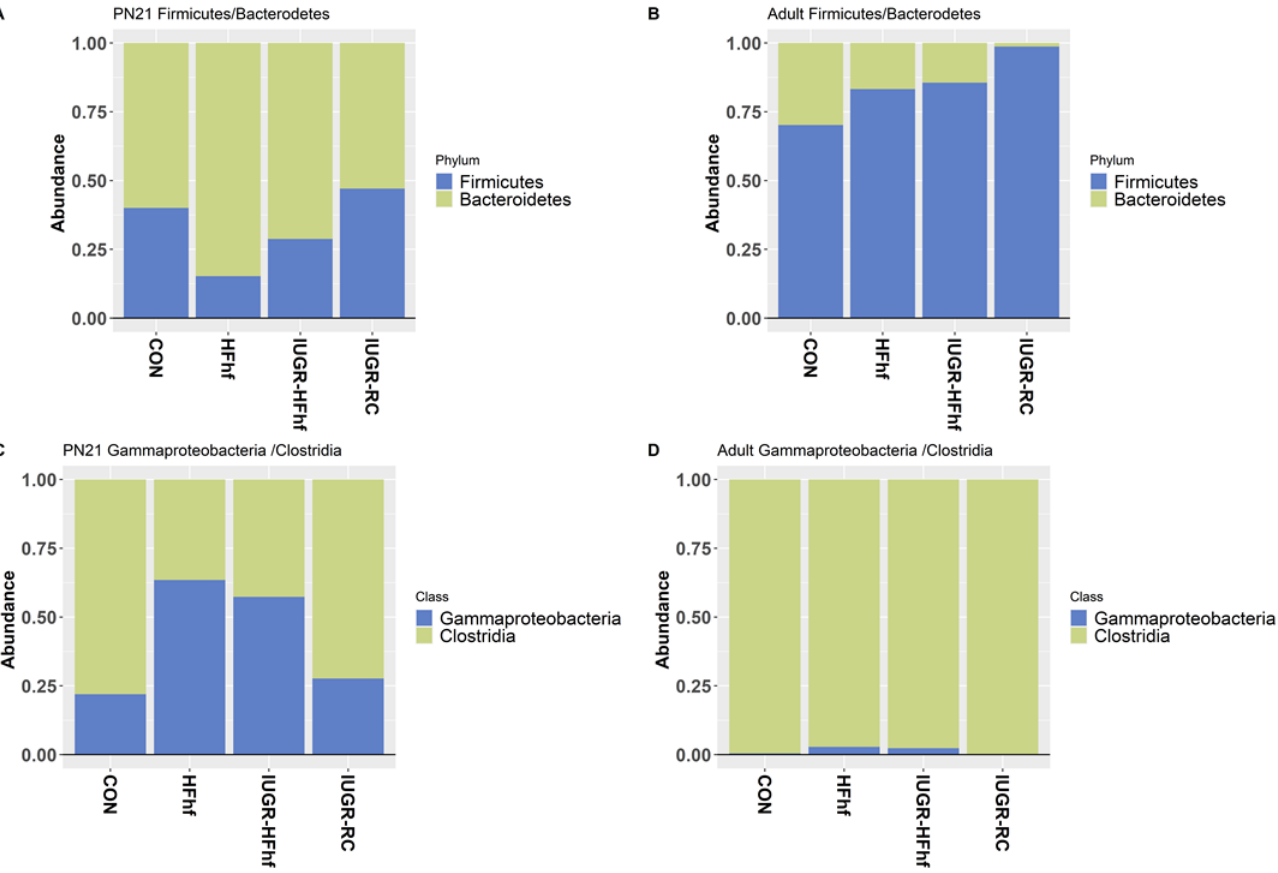
Figure 7. Stacked bar plots showing the ratio of Firmicutes to Bacteroidetes ( A , B ) and Gammapro- teobacteria to Clostridia ( C , D ) among different dietary groups . teobacteria to Clostridia ( C , D ) among different dietary